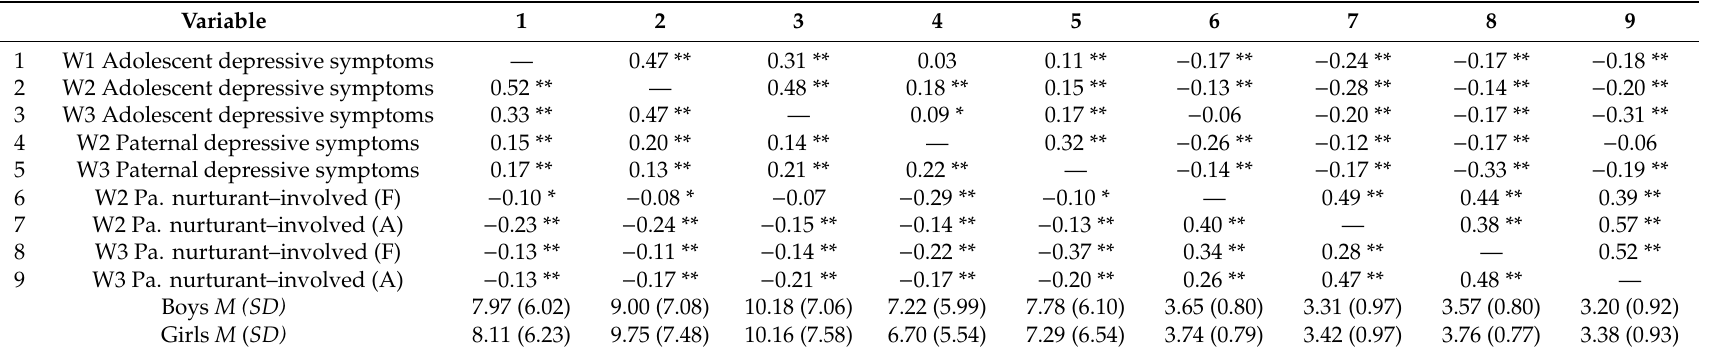
Table 2. Descriptive statistics for the study variables (father–adolescent) by adolescents’